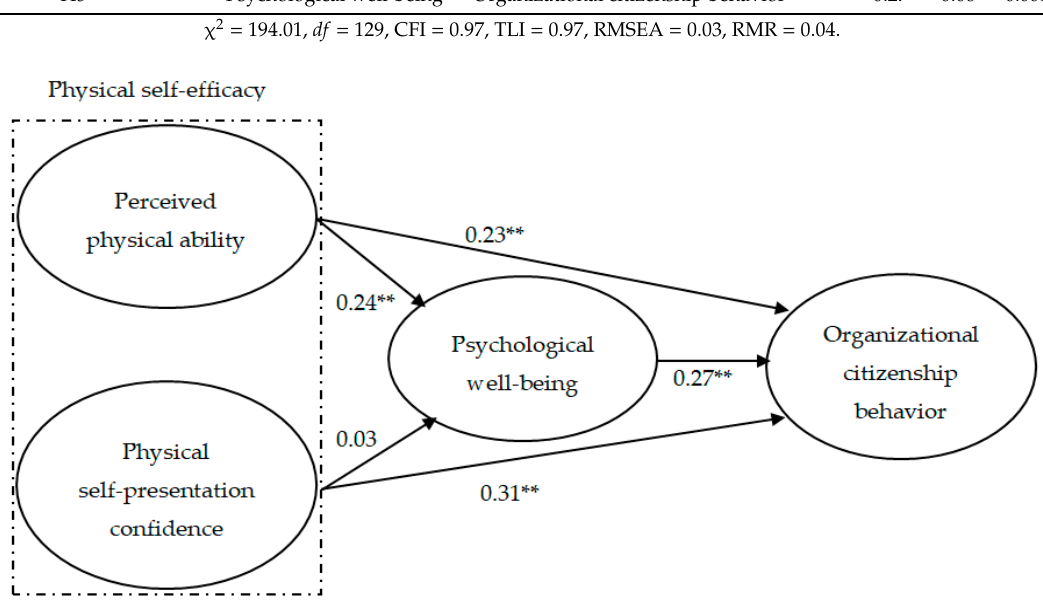
Figure 2. Path coe ffi cients between physical self-e ffi cacy, psychological well-being, and organizational Figure 2. Path coefficients between physical self-efficacy, psychological well-being, and citizenship behavior. ** p < organizational citizenship behavior . ** p < 0.01